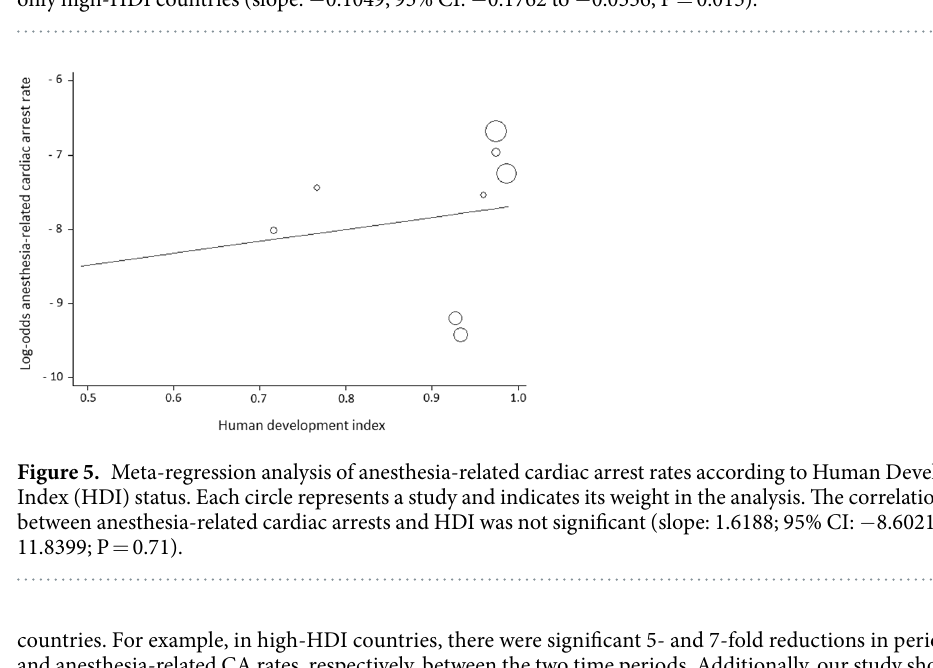
Figure 4. Meta-regression of anesthesia-related cardiac arrest rates according to time. Each circle represents a study and indicates its weight in the analysis. ( A ) The correlation between anesthesia-related cardiac arrests and time was significant considering both low- and high-HDI countries (slope: − 0.0699; 95% CI: − 0.1394 to − 0.0003; P = 0.04). ( B ) The correlation between anesthesia-related cardiac arrests and time was significant in only high-HDI countries (slope: − 0.1049; 95% CI: − 0.1762 to − 0.0336; P = 0.015).